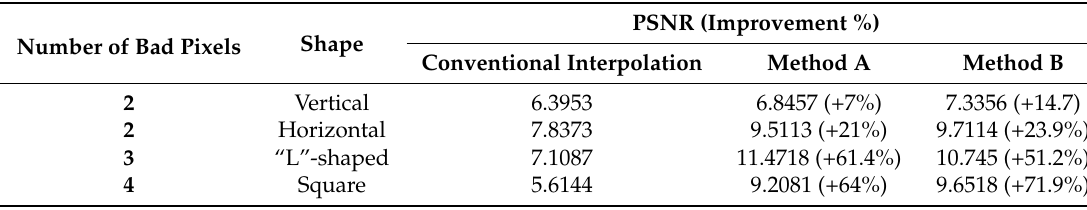
Table 1. PSNR of correction for bad pixels appearing in the ROI.